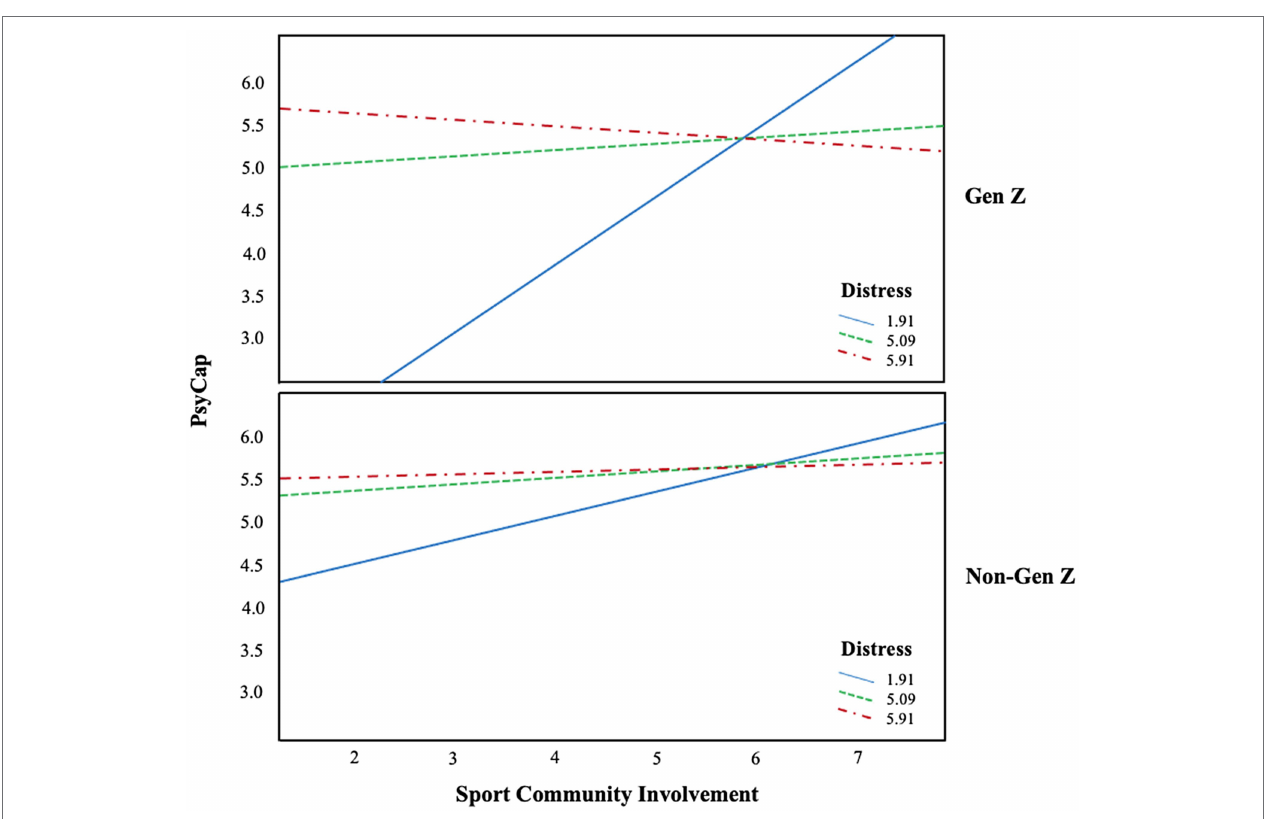
FIGURE 2 | The three-way interaction effect. Solid line represents low distress level at 16th percentile; dotted line represents medium distress level at 50th percentile; and dash-dotted line represents high self-esteem level at 84th